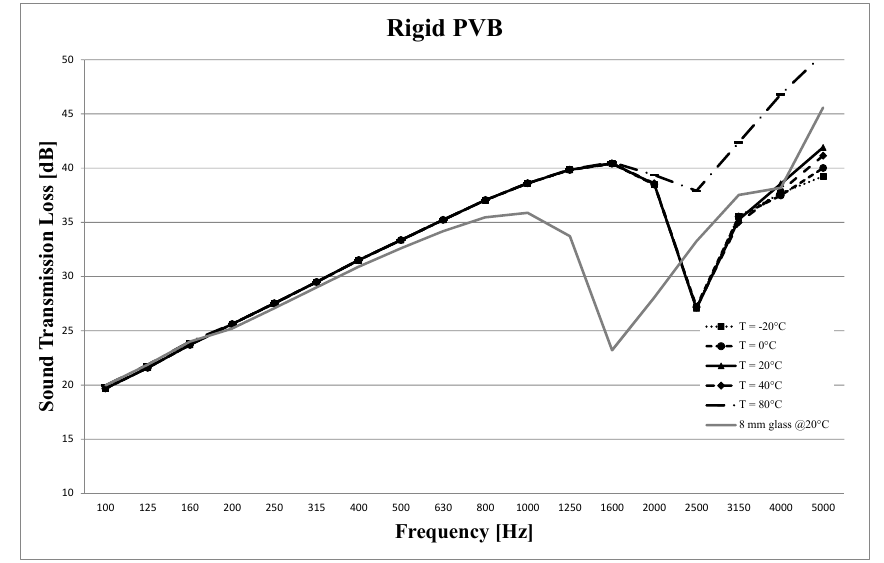
Fig. 15 Sound Transmission Loss Curves of glasses laminated with rigid PVB at different temperatures Fig. 16 shows the comparison between the STL of standard, acoustic and rigid PVB at different temperatures. Rigid PVB at 80°C and standard PVB at 40°C behave similarly to the acoustic PVB at ambient temperature. Standard PVB as well as rigid PVB soften at higher temperatures that results in a better dampening. EVA at room temperature and ionomer at 80 °C were also included for comparison; their dip is more significant than in case of